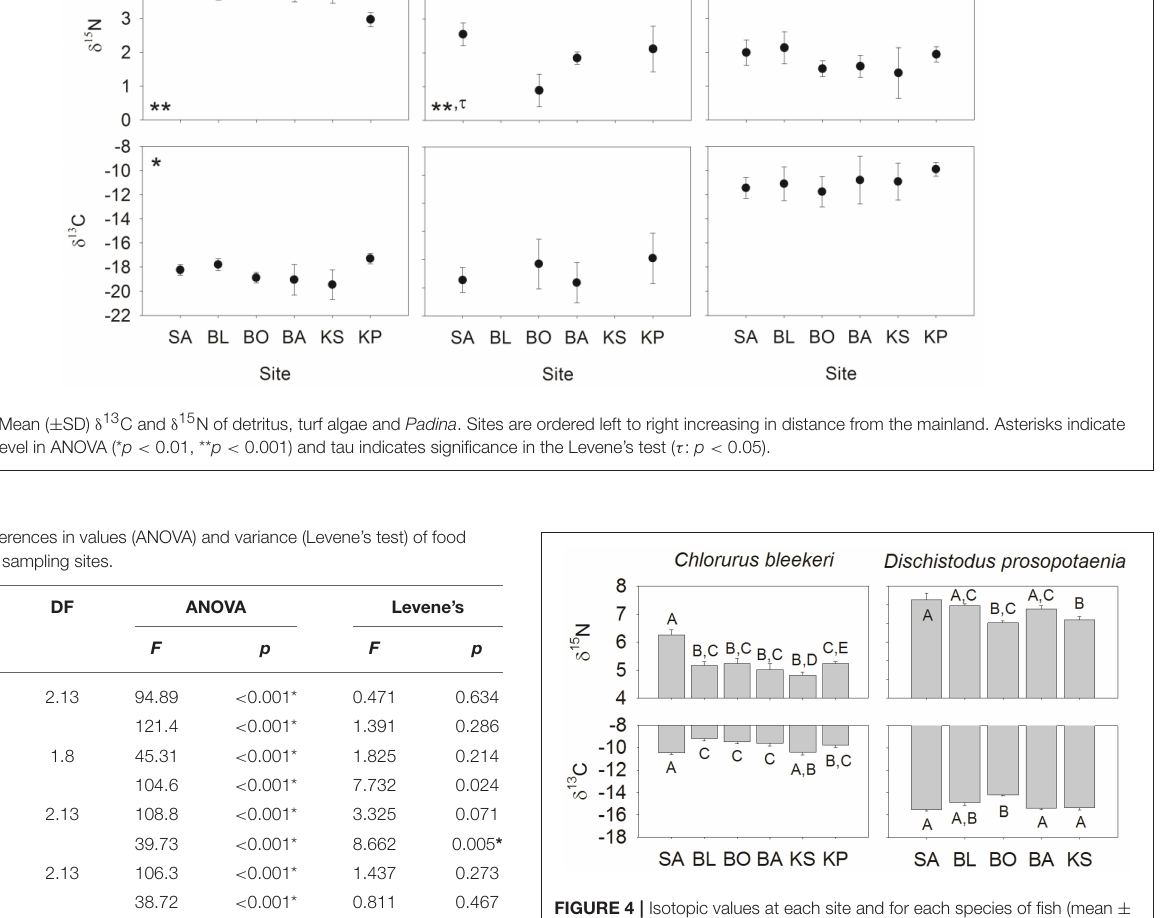
FIGURE 4 | Isotopic values at each site and for each species of fish (mean ± SE). Sites are listed from left to right increasing in distance from the mainland. Lettering indicates homogenous subgroups as identified by PERMANOVA. Lettering is independent for each species ×